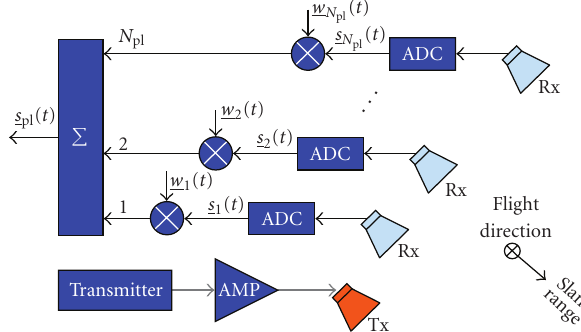
Figure 2: General system architecture for planar system; some components such as LNAs, mixers, filters etc. are not shown to maintain a clear